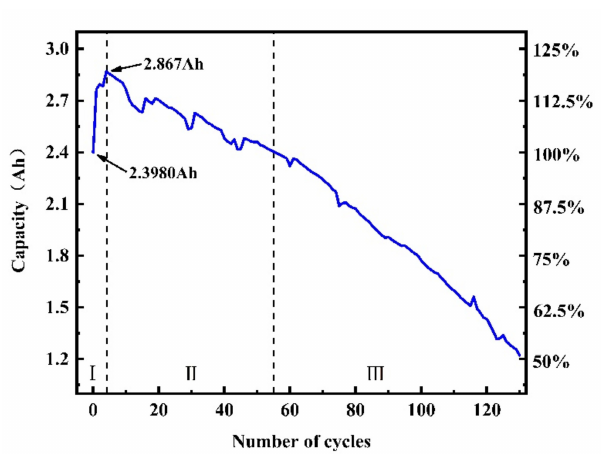
Figure 3. The discharge capacity changes of a -type NCM811 battery during 130 cycles at the cycle ratio of 2 C with the cut-off voltage of 1